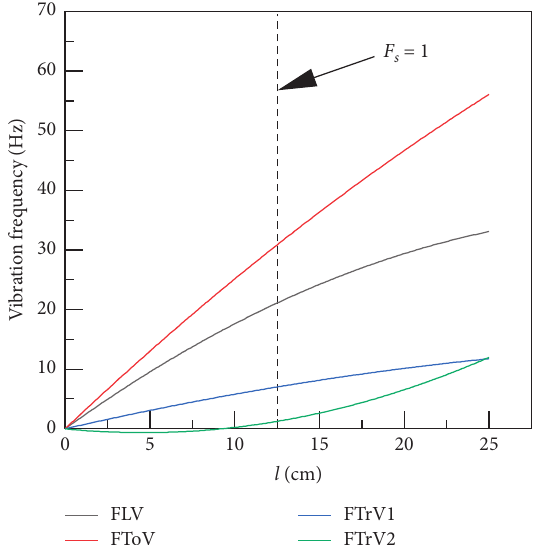
Figure 4: Calculation of natural frequency thresholds for rock instability.